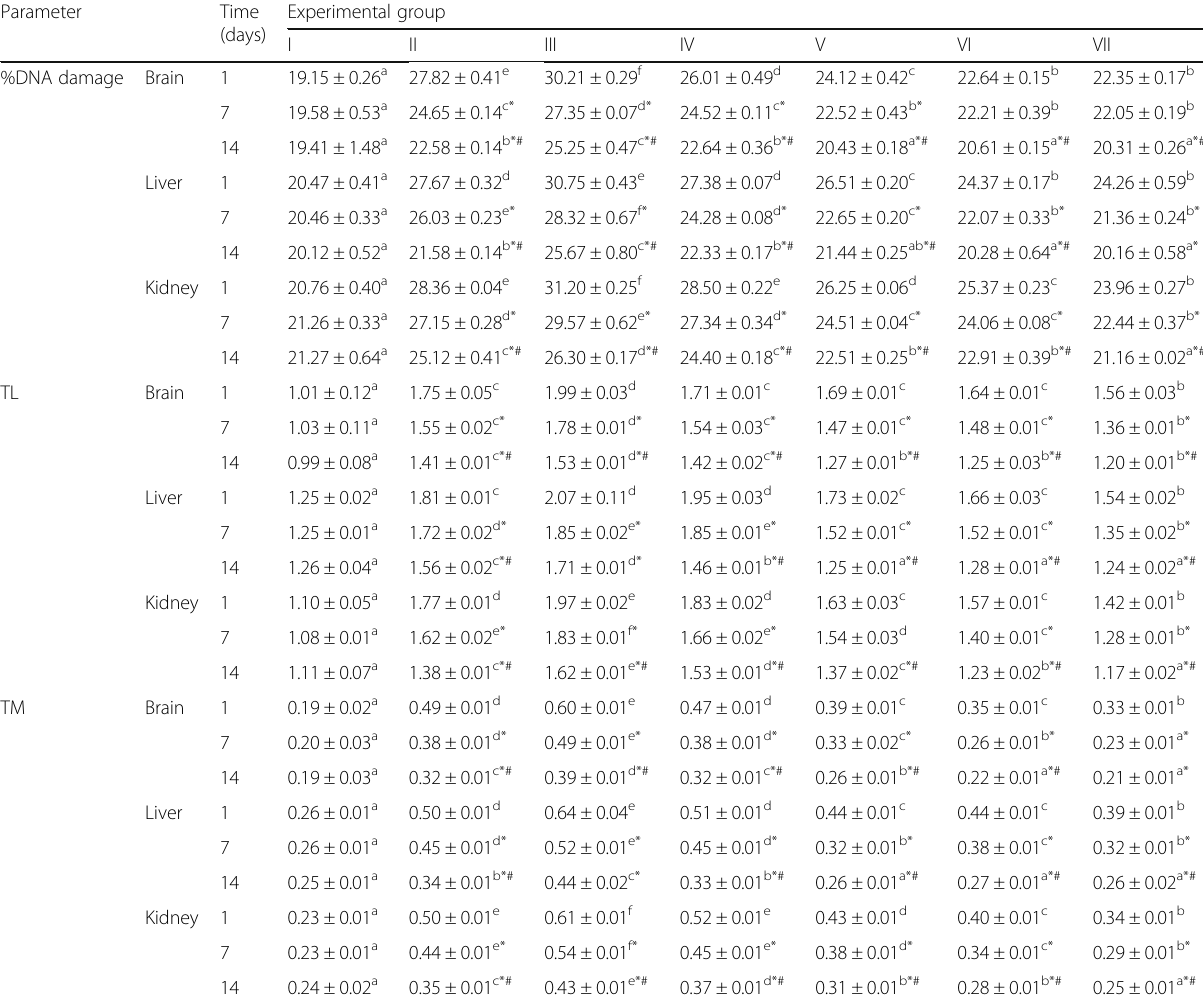
Table 6 The percentage of DNA damage (%DNA), tail length (TL), and tail moment (TM), after 1, 7, and 14 days in the brain, liver, and kidneys of control rats (I), and those administered 0.5 g and 1.0 g of NiO-NPs (II and III), 0.5 g and 1.0 g of Co 3 O 4 -NPs (IV and V) as well as mixtures of NiO-NPs + Co 3 O 4 -NPs (0.25 g + 0.25 g, VI) and (0.5 g + 0.5 g, VII) per kilogram body weight, respectively